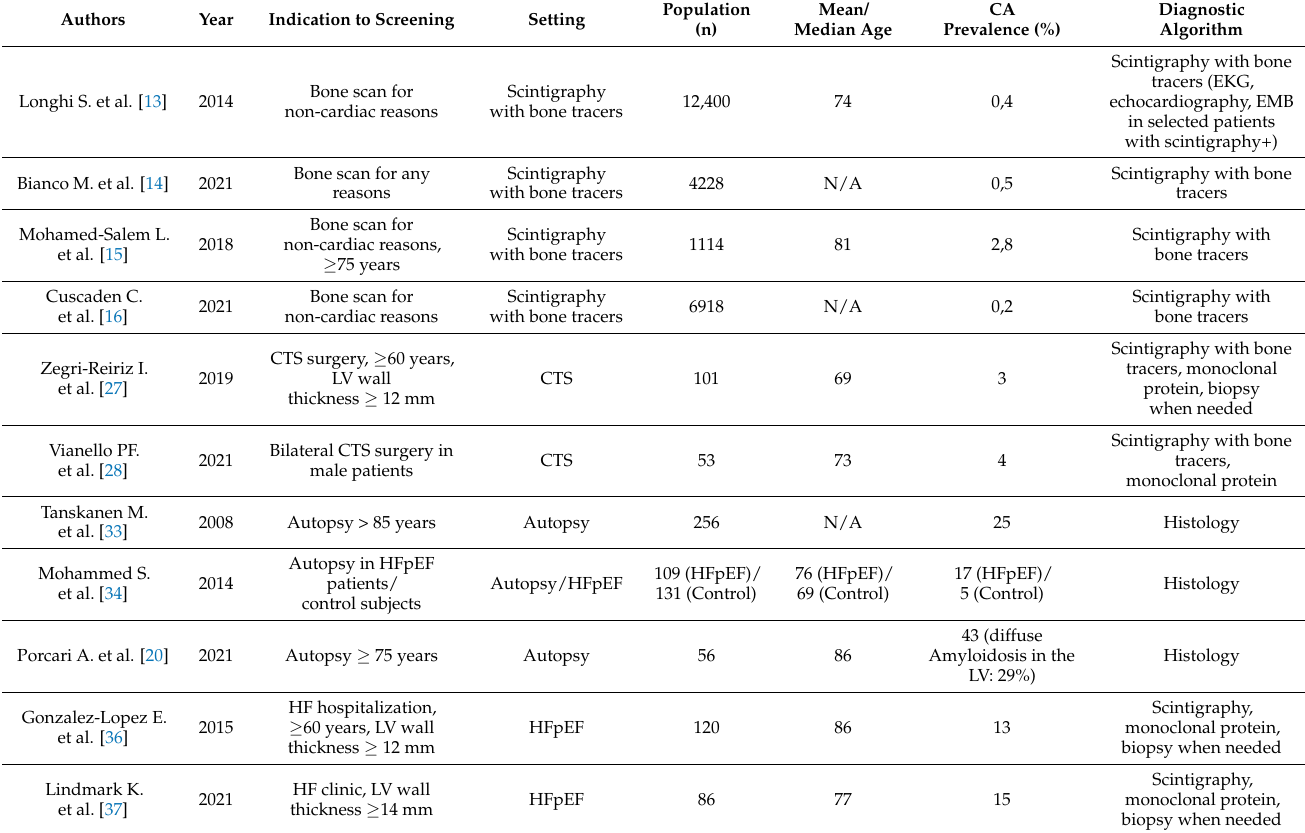
Table 1. Screening studies on CA in different